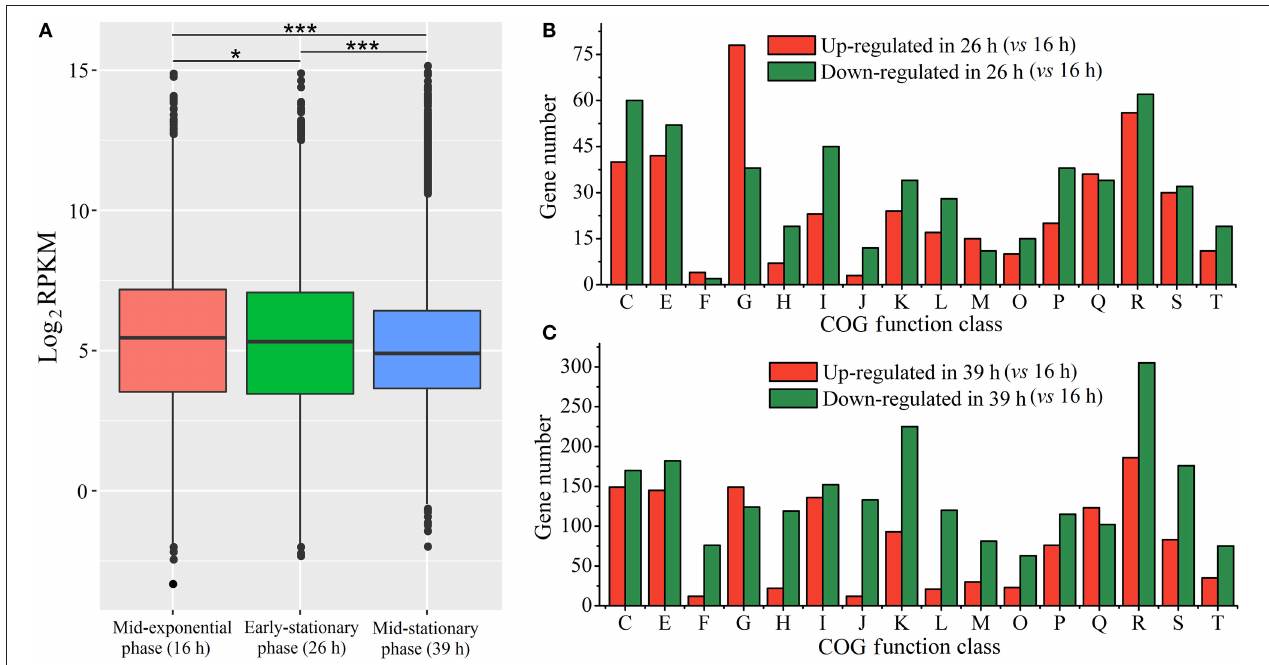
FIGURE 2 | Gene expression levels in RNA-seq data. (A) The median expression levels of different growth phases measured by RPKM for whole identified genes. RPKM values of each sample were analyzed using Wilcoxon test, * p < 0.05, ** p < 0.01, *** p < 0.001. (B,C) respectively indicate the number of DEGs in distinct COG functional categories at the early-stationary phase (26h) and mid-stationary phase (39h). The COG functional categories are as follows: C, energy production and conversion; E, amino acid transport and metabolism; F, nucleotide transport and metabolism; G, carbohydrate transport and metabolism; H, coenzyme transport and metabolism; I, lipid transport and metabolism; J, translation, ribosomal structure and biogenesis; K, transcription; L, replication, recombination and repair; M, cell wall/membrane/envelope biogenesis; O, posttranslational modification, protein turnover, chaperones; P, inorganic ion transport and metabolism; Q, secondary metabolites biosynthesis, transport and catabolism; R, general function prediction only; S, function unknown; T, signal transduction